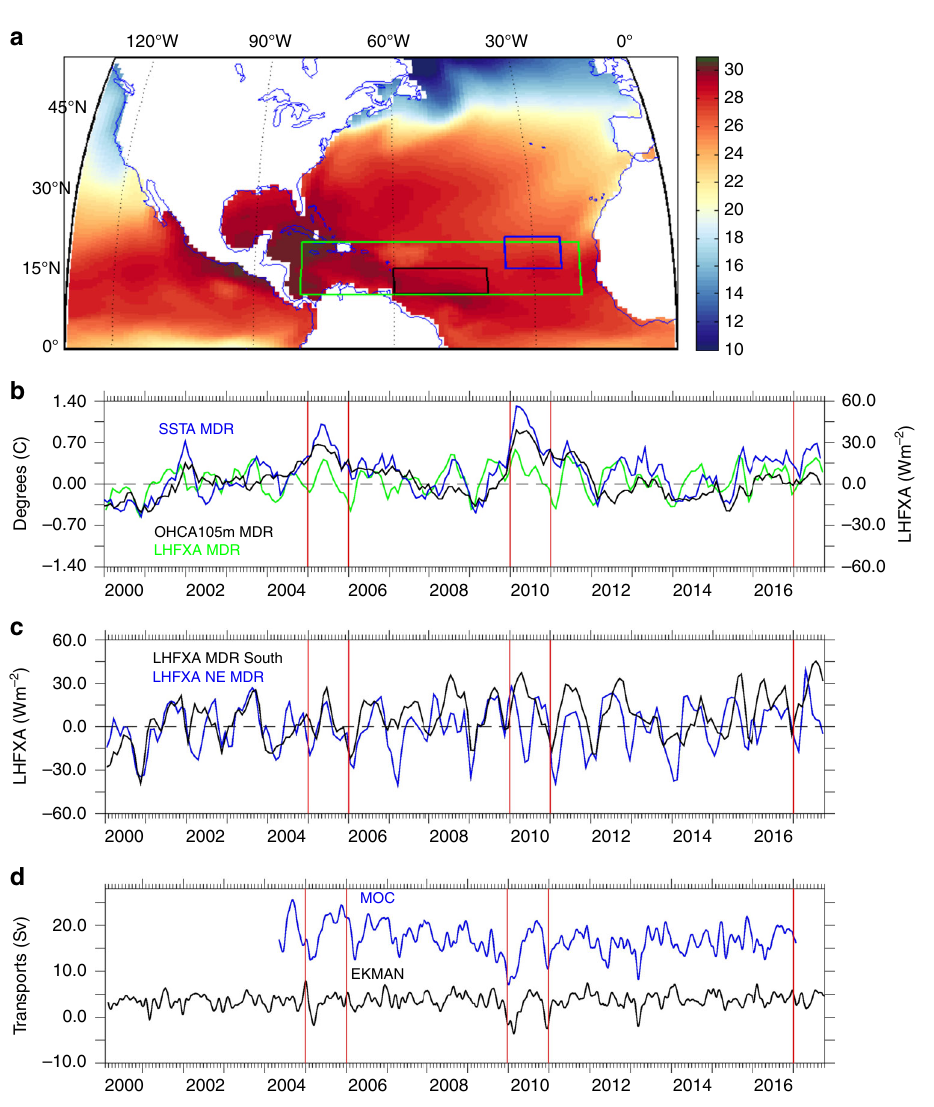
Fig. 3 Atlantic time series and map outlining the study region. a SST September 2017: green box: MDR region 10 – 20°N and 20 – 80°W, black box: southern MDR region 10 – 15°N and 40 – 60°W, blue box: north-eastern (NE) MDR 15 – 21°N, 24 – 36°W. b – d Observed Atlantic time series: b monthly SSTA, OHCA105m and LHFXA in the MDR; c monthly latent heat fl ux anomalies (LHFXA) in the southern MDR and NE MDR smoothed over 3 months; and d MOC and Ekman Transports 12-hourly data smoothed over 61 days by applying a low pass fi